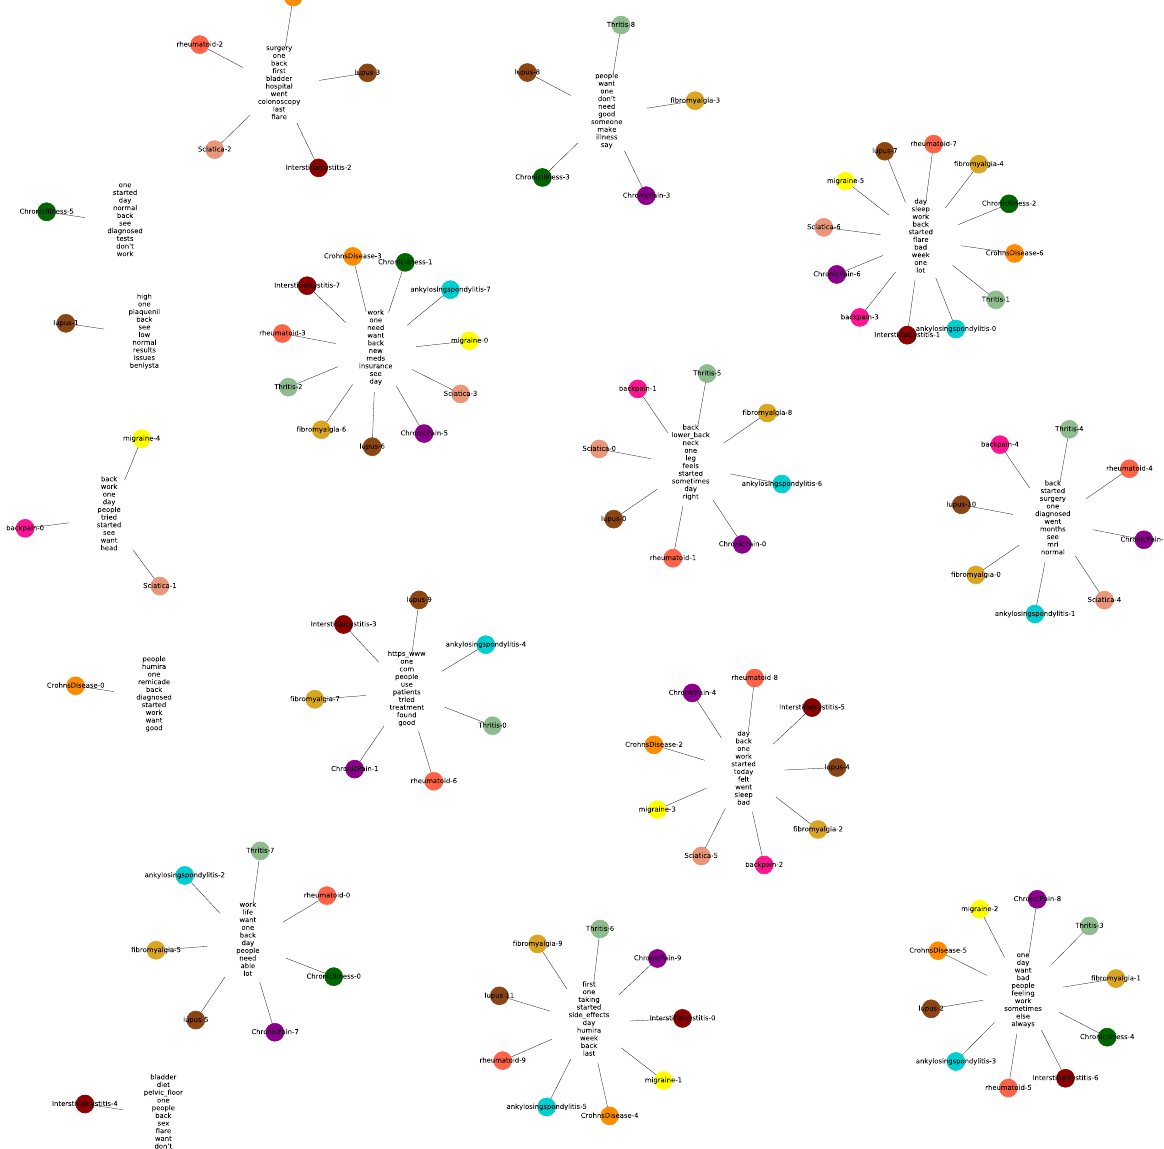
Figure 2. Petal graph between all subreddit centroids (nodes, colored by subreddit). Node label indicates the corresponding subreddit and centroid sequential number. Sub-graphs indicate connected components with similarities ≥ 0.9. Each sub-graph is characterized by the top-10 TFIDF scoring tokens of the subset of documents that belong to it.